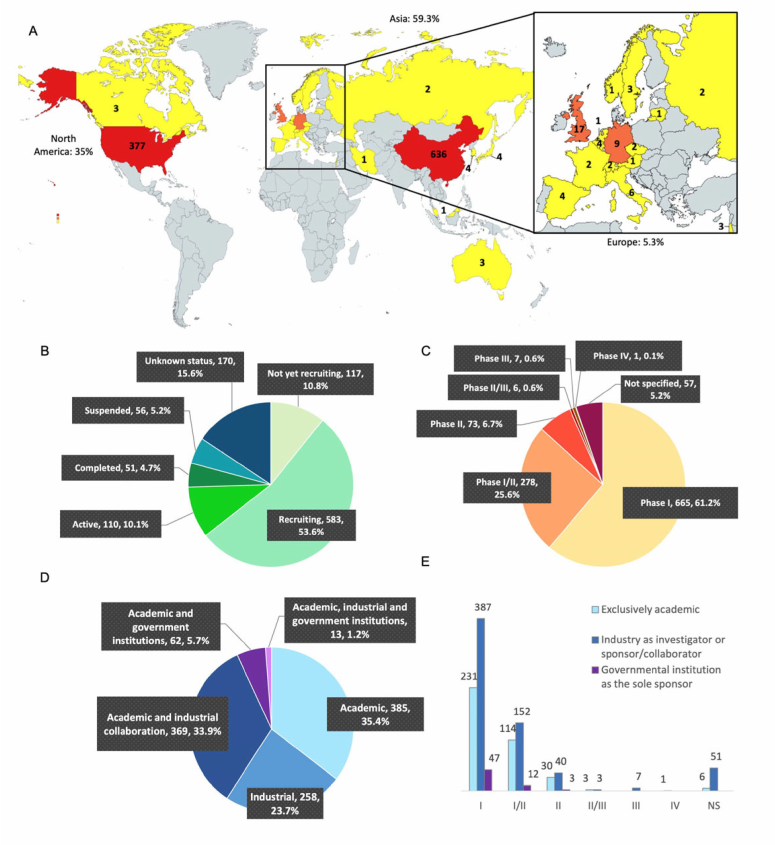
Figure 2. Distribution of CAR-T cell clinical trials in the world in 2022. ( A ) Geographical distribution: The United States and China dominate in number of studies, with 377 (34.7%) and 636 (58.5%) studies, respectively. North America is also represented by Canada (3 studies). Apart from China, the Asian countries have 9 studies (0.8%) with Japan (4), South Korea (4), Malaysia (1) and Iran (1). Europe has 58 studies (5.3%): UK (17), Germany (9), Italy (6), Belgium (4), Spain (4), Sweden (3), Israel (3), Switzerland (2), Czech Republic (2), Russia (2), France (2), Lithuania (1), Netherlands (1), Austria (1), and Finland (1). Mapchart.net. ( B ) Status distribution: 117 studies have not started the recruitment (10.8%), 583 are currently recruiting patients (53.6%), 110 are active (10.1%), 51 have been completed (4.7%), 56 have been discontinued (5.2%), and 170 have unknown status (15.6%). ( C ) Study phases: 665 studies are in phase I (61.2%), 278 in phase I/II (25.6%), 73 in phase II (6.7%), 6 in phase II/III (0.6%), and 7 in phase III (0.6%). One study is in phase IV (0.1%) and 57 studies